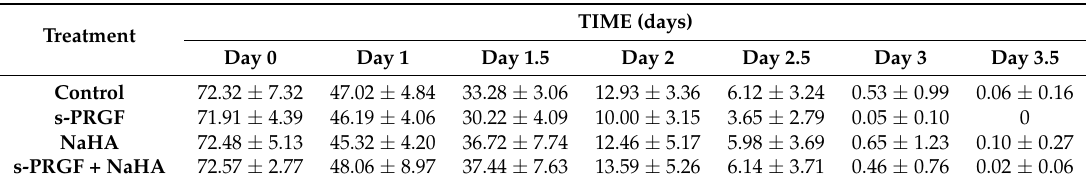
Figure 5. Re-epithelialization of corneal defects in rabbit eyes. ( A ) Evolution of the epithelial defect was monitored with fluorescein staining in eyes treated with topical s-PRGF, s-PRGF and NaHA, NaHA, or PBS as a control treatment. ( B ) Histological sections of rabbit central corneas after complete healing were stained with hematoxylin and eosin. Corneas were processed seven days after surgery or at 30 days. Scale bar: 5 mm for ( A ), 50 µm for ( B ). Table 1. In vivo experiment assessing the progression of epithelial wound healing in rabbit eyes treated with s-PRGF, s-PRGF and NaHA, NaHA, and PBS as the control. The results are expressed as mean wound area ± standard deviation in mm 2 .